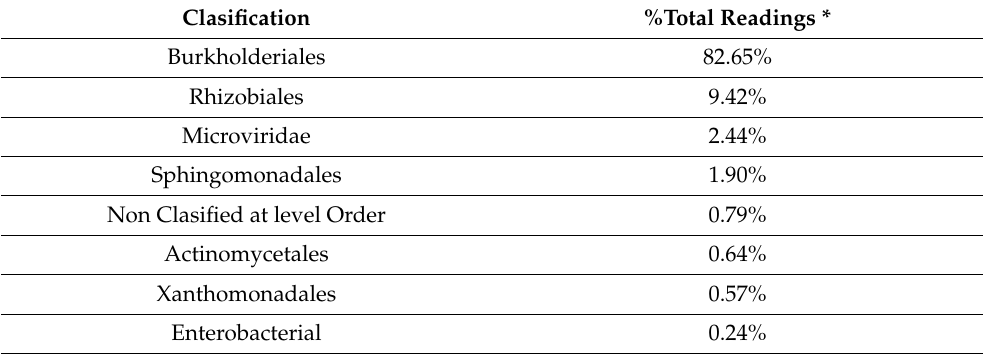
Table 1. Identification by orders of rubber degradation in the consortium.